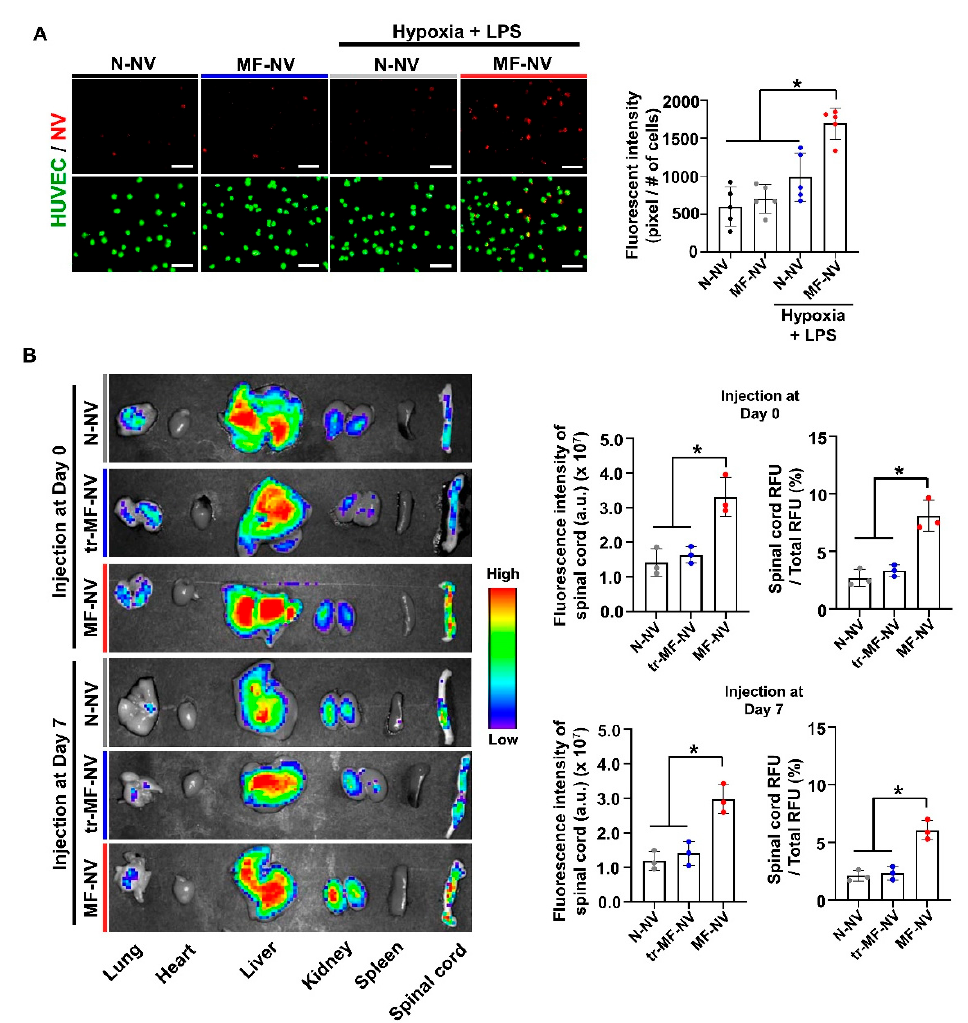
Figure 6. In vitro and in vivo enhanced targeting efficiency of MF-NV. ( A ) Fluorescent images and the quantification data of NV binding to HUVECs in vitro (n = 5 per group). Scale bars, 100 µ m. * p < 0.05 by using one-way ANOVA followed by post-hoc Bonferroni test. ( B ) Biodistribution of N-NVs, MF-NVs, and tr-MF-NVs in injured spinal cord 24 h after injection 1 h and 7 days post-injury (n = 3 animals per group). Fluorescently labeled NVs were intravenously injected 1 h and 7 days after injury. * p < 0.05 by using one-way ANOVA followed by post-hoc Bonferroni test. All values are mean ± SD.